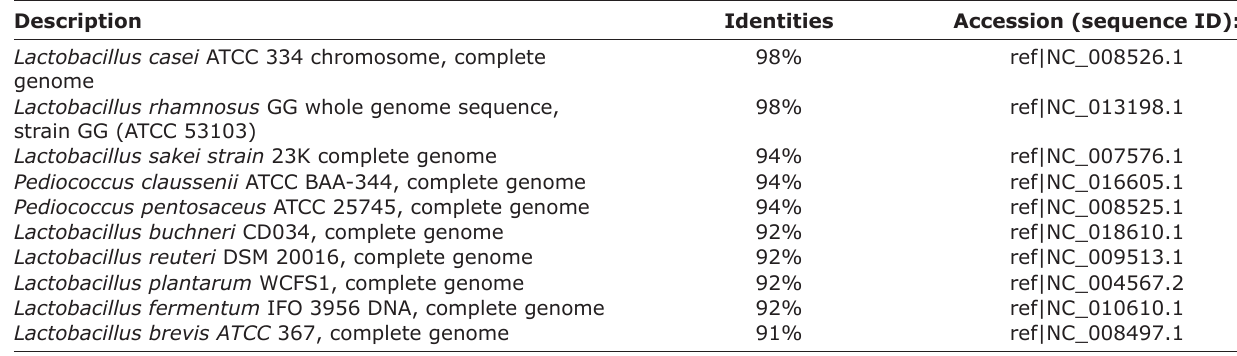
Table-1: Similarity identity